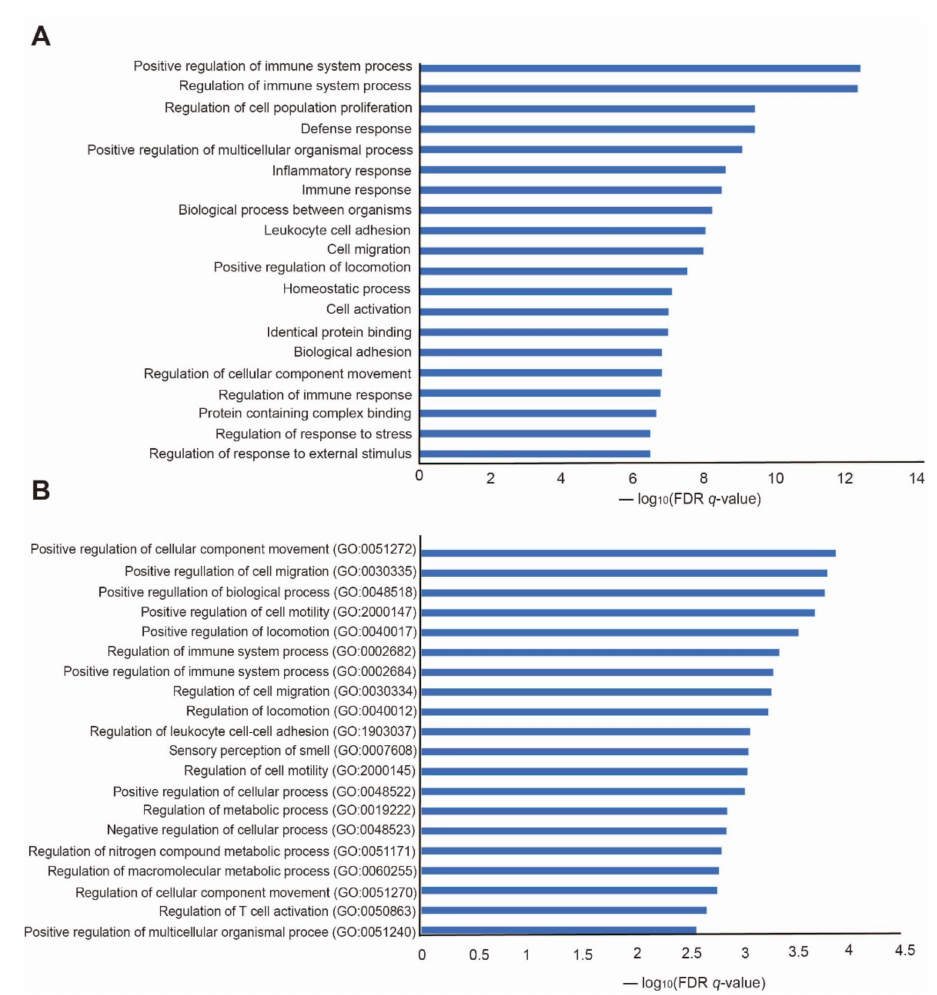
Figure 3. Functional analysis of genes with increased expression in BDL mouse groups. ( A ) KEGG pathway analysis for genes with increased expression in the BDL mouse group. The significantly changed pathways based on the false discovery rate (FDR) q -value are shown. ( B ) GO analysis for genes with increased expression in the BDL mouse group. The top 20 GO terms based on the FDR q -value are